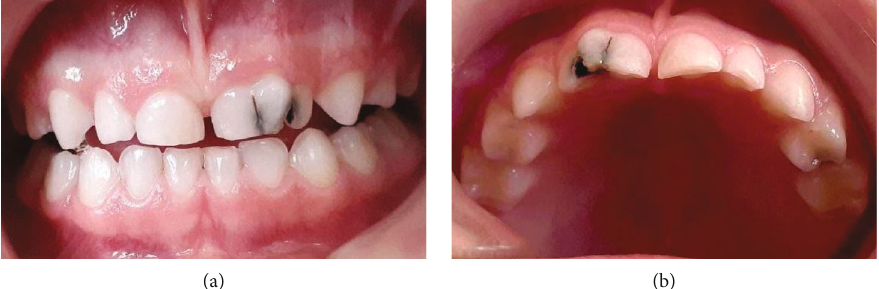
Figure 1: Intraoral photographs. Carious large crown of tooth 61 associated with dental caries of tooth 62 (a). Occlusal photograph showing the anterior teeth nonalignment and distal rotation of tooth 61 (b).